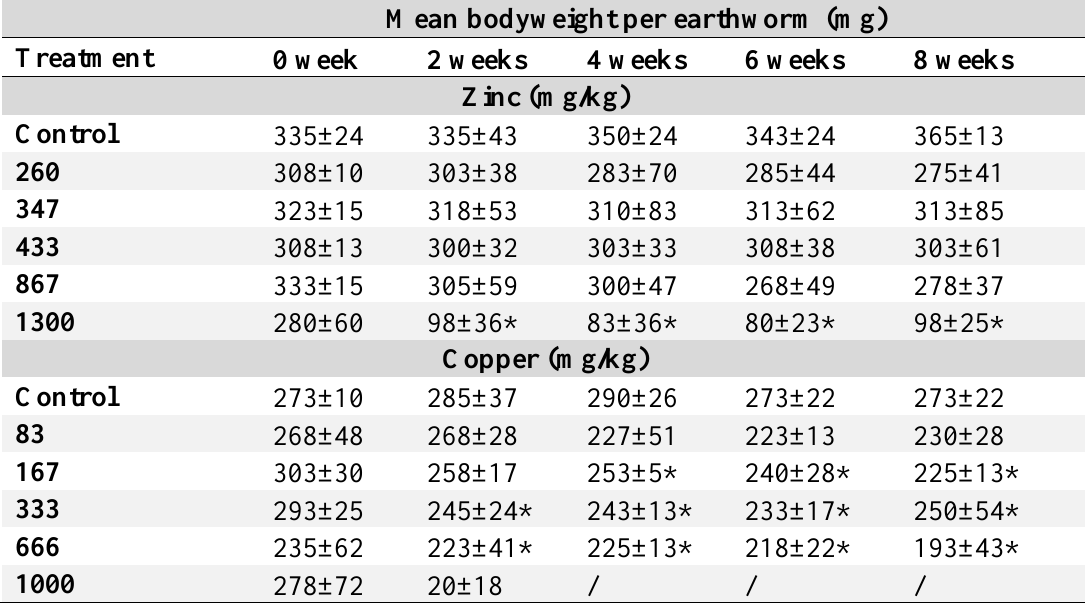
Table 1. Growth of the juvenile earthworm Eisenia fetida exposed to copper and zinc during eight